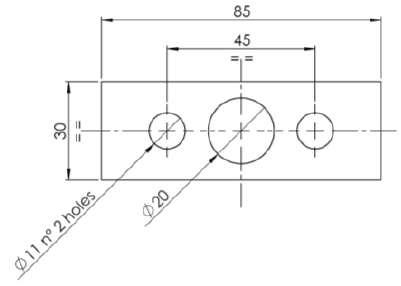
Figure 2. Slow strain rate test (SSRT) sample.